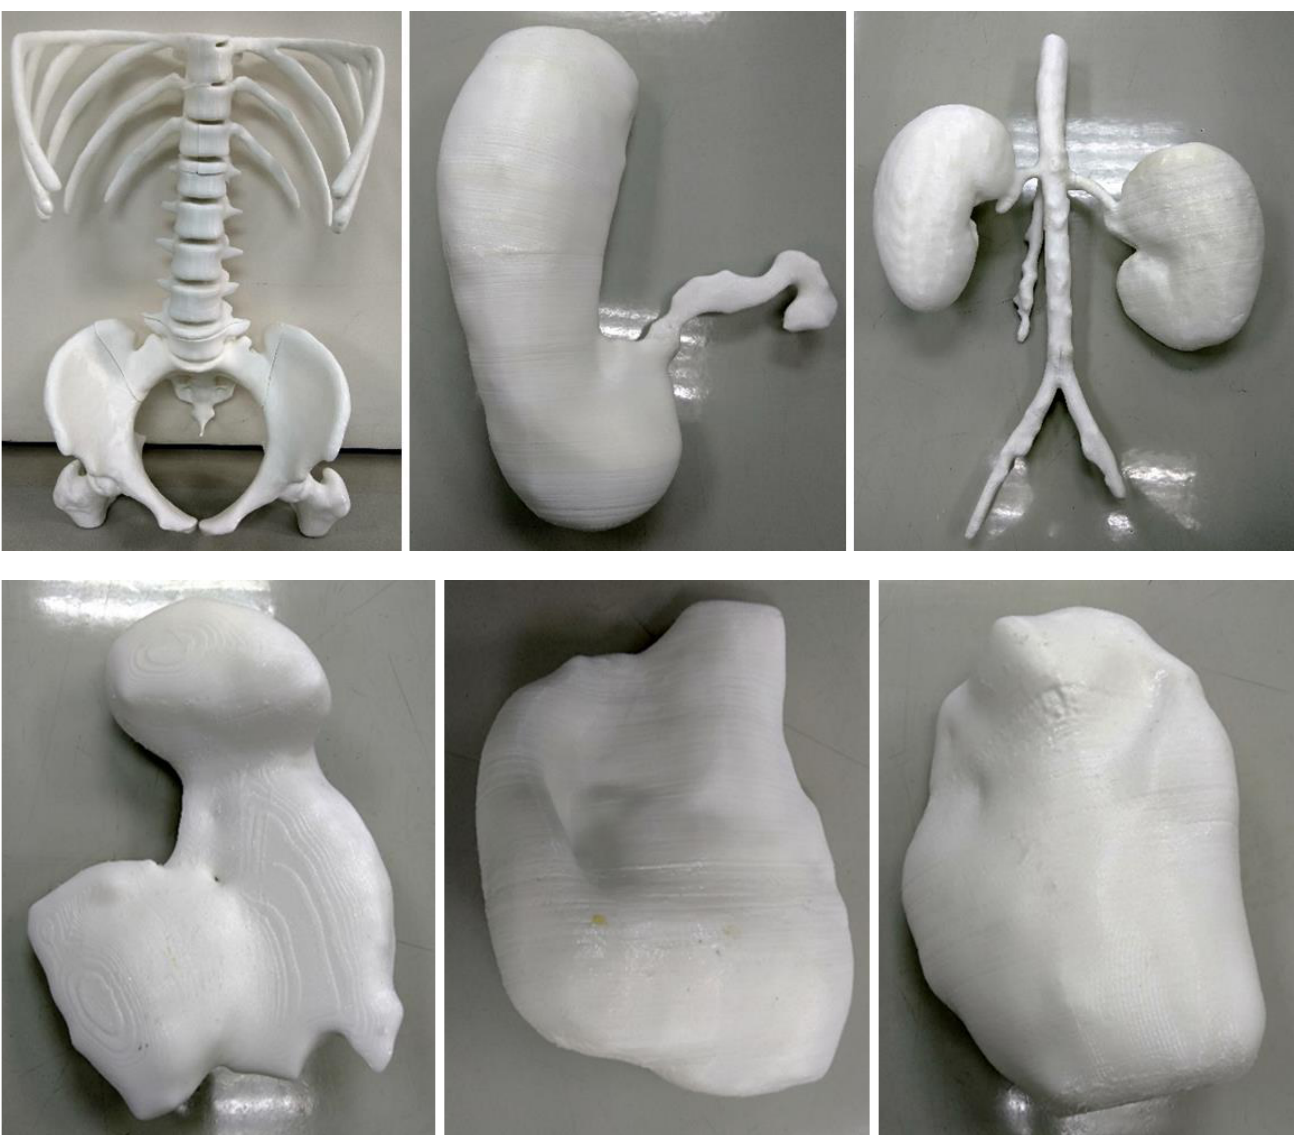
Figure 23. 3D-printed models of abdominal organs except for the small and large intestines. Top row from left to right: 3D-printed skeleton, stomach, kidneys and abdominal aorta models. Bottom row from left to right: 3D-printed spleen, bladder and uterus models. Reprinted with permission from Etherton et al. [88].